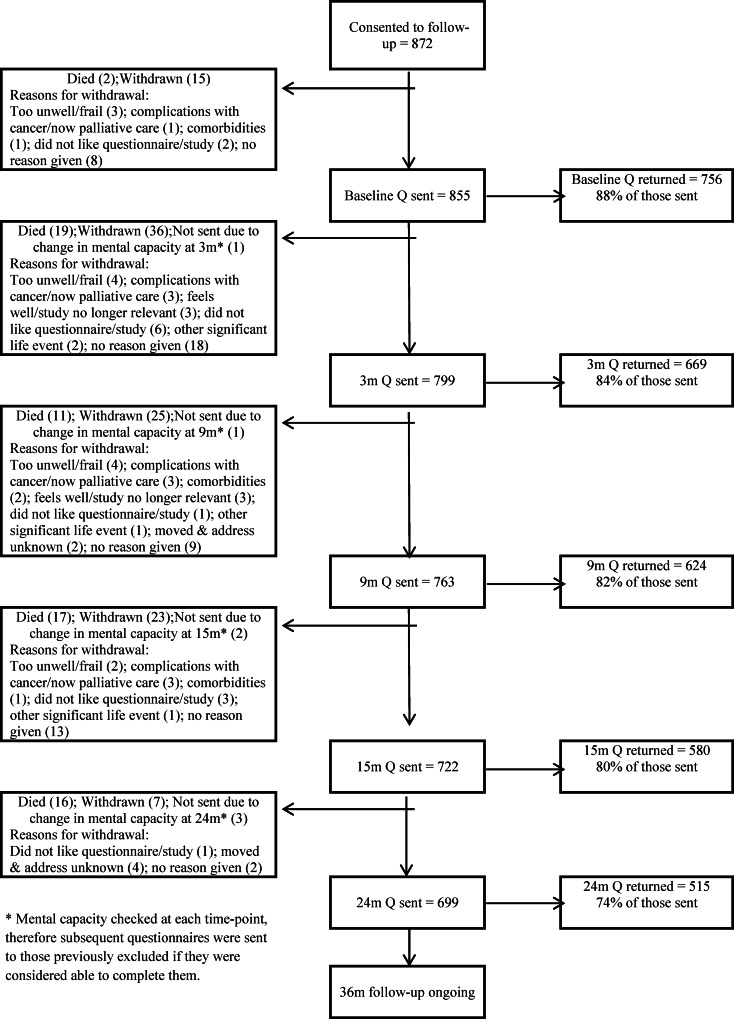
Participant status and questionnaire return rates up to 24 months of follow-up.Number of questionnaires sent and returned at each time-point up to 24 months, with details of deaths and withdrawals throughout the study.